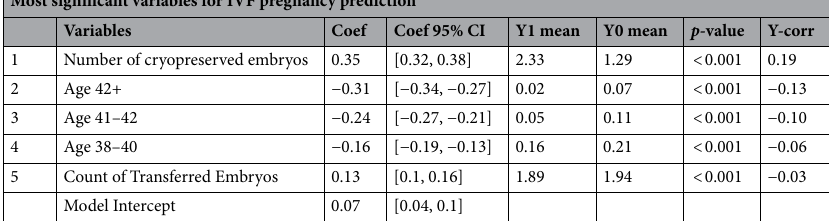
Table 3 . Predictive IVF success model with only the 5 most important